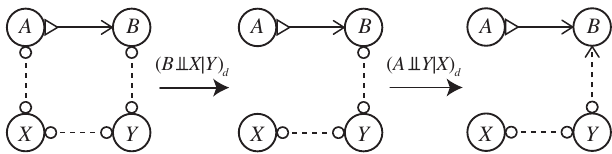
FIG. 7. Shortcut graphical notation for any causal link between X and Y .